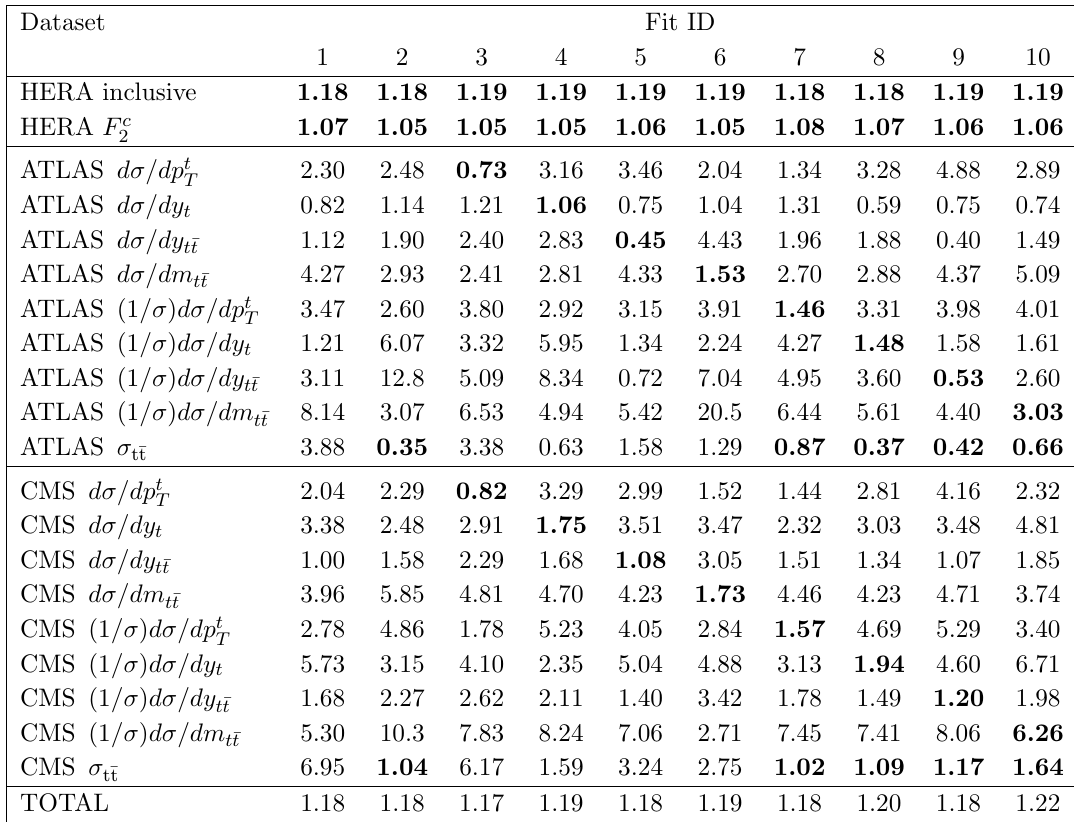
Table 6 . The (cid:31) 2 from the HERA-only PDF (cid:12)ts for various combinations of top-quark data. The numbers in boldface indicate the datasets included in the (cid:12)t, while the other entries describe the quality of the predictions of the resultant PDF (cid:12)t for the other